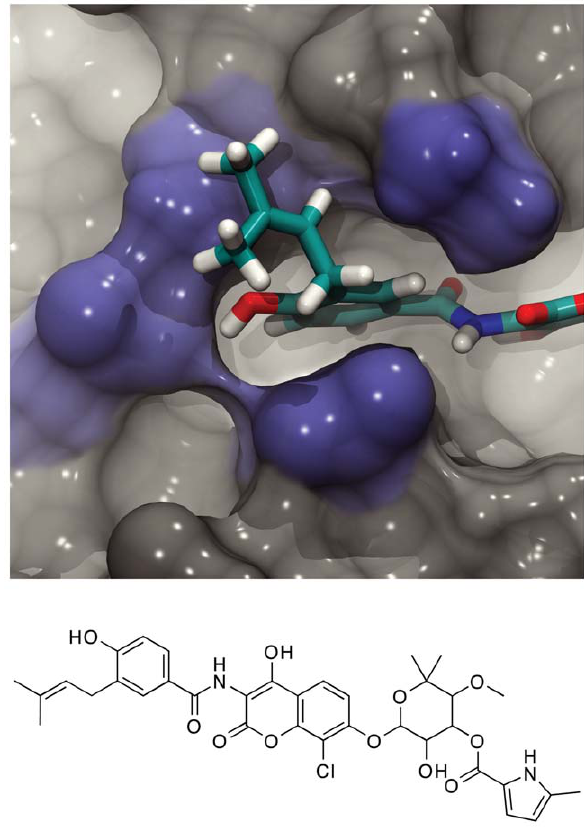
Figure 3. The binding of compound 1 to the semi-open conformation of cruzain. Compound 1 (clorobiocin, bottom), a known antagonist of T. cruzi amastigote growth, is predicted to occupy a previously uncharacterized binding pocket adjacent to the S2 subsite (top).